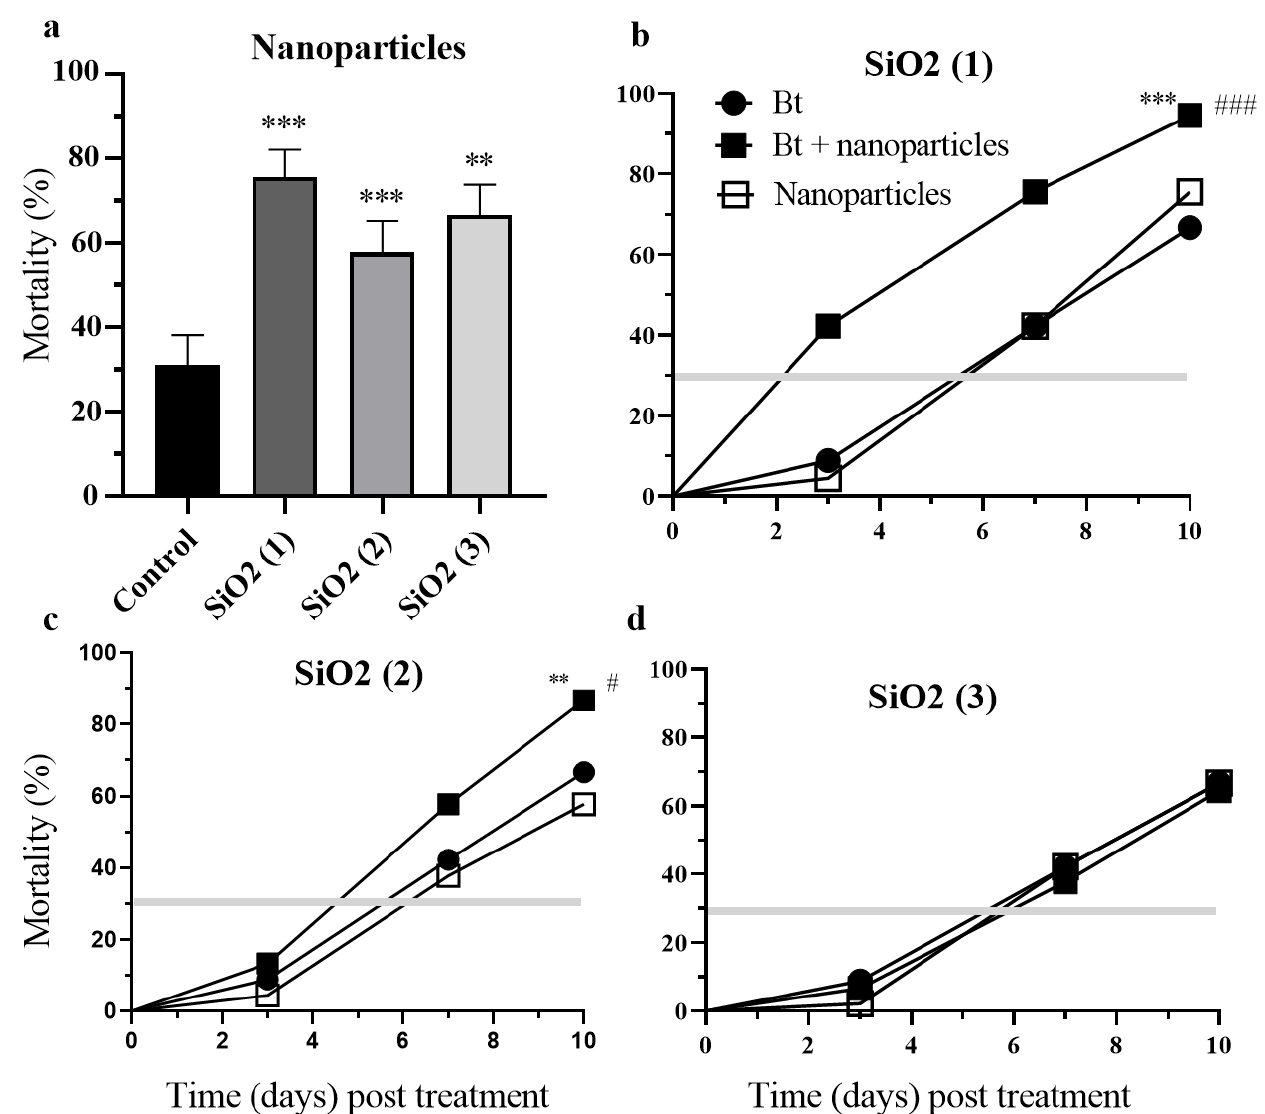
Figure 3. Survival of crucifer flea beetles Phyllotreta spp. imagoes over ten days following treatment with silicon dioxide nanoparticles with epoxy (1 SiO 2 ), silane (2 SiO 2 ), amino (3 SiO 2 ) groups ( a ), bacteria Bacillus thuringiensis (Bt) and combination (Bt + nanoparticles) ( b – d ) (** p < 0.01, *** p < 0.001 compared with native beetles (Control) ( a ); (** p < 0.01 compared with treatment by nanoparticles, # # p < 0.05 compared with treatment by Bt, ### p < 0.05 compare with treatment by Bt) ( b – d ).